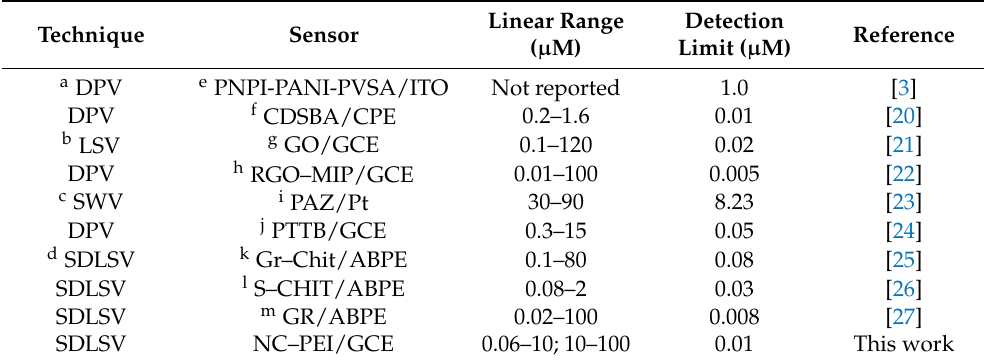
Table 1. Performance comparison of the NC–PEI/GCE for 4-NP detection with other electro- chemical